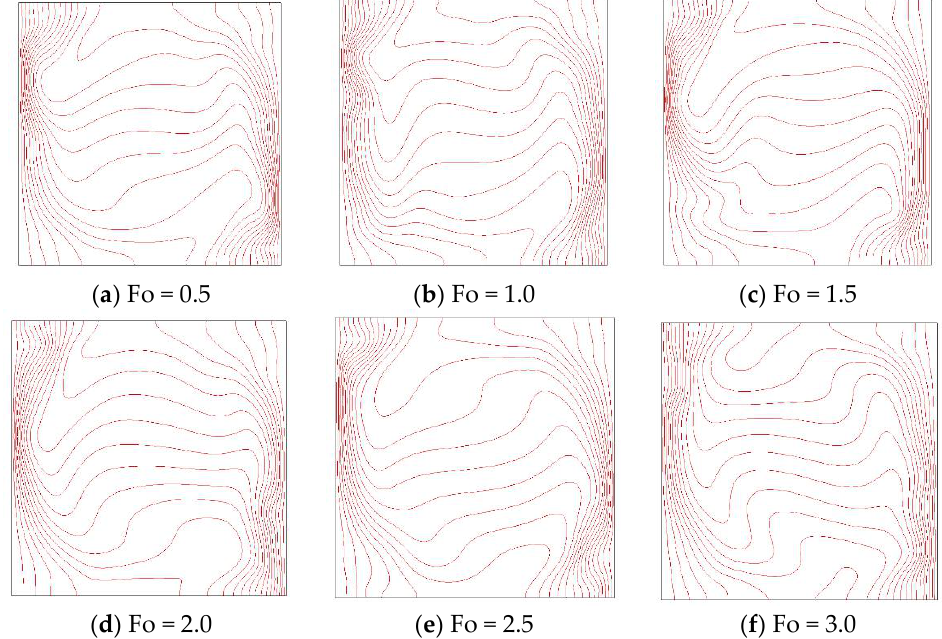
Figure A2. Isotherms at different times ( a – f ) for natural convection in a side-heated square cavity. Pr = 0.01. The isotherms never reach the steady-state at low Prandtl numbers. The isotherm and streamline plots show that a steady-state cannot be reached.